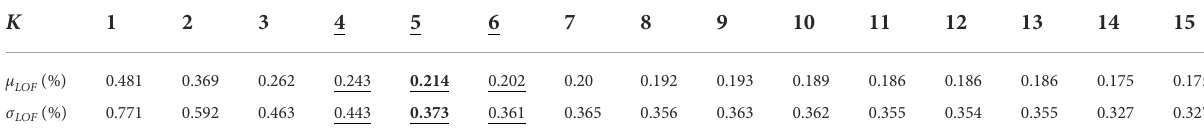
TABLE 1 LOF evolution according to the number of components. First row is the number of components K extracted by MCR, second row is the LOF mean μ LOF (inpercent),andthirdrowistheLOFstandarddeviation σ LOF